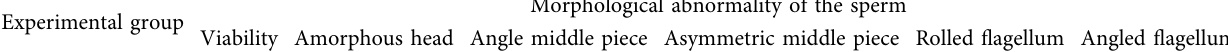
Table 2: Sperm parameters. Morphological abnormality of the sperm